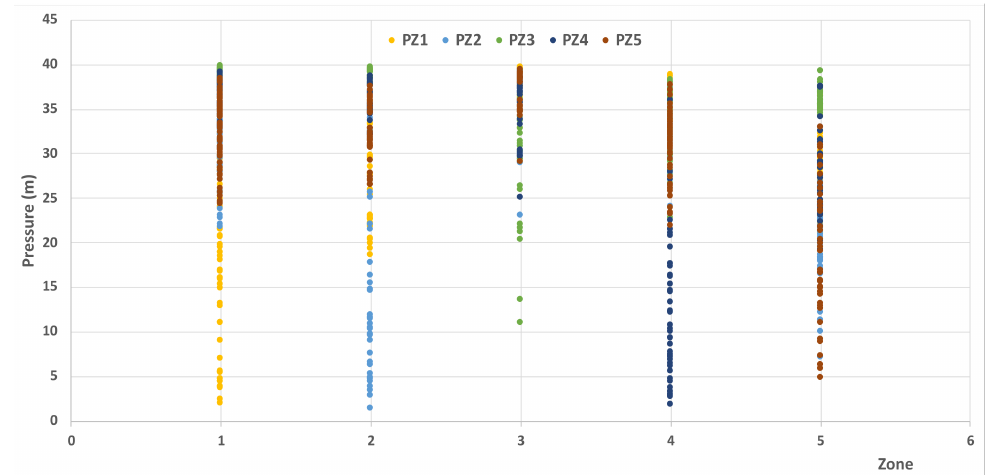
Figure 4. Impact of the leak localization on the pressure values at the observation